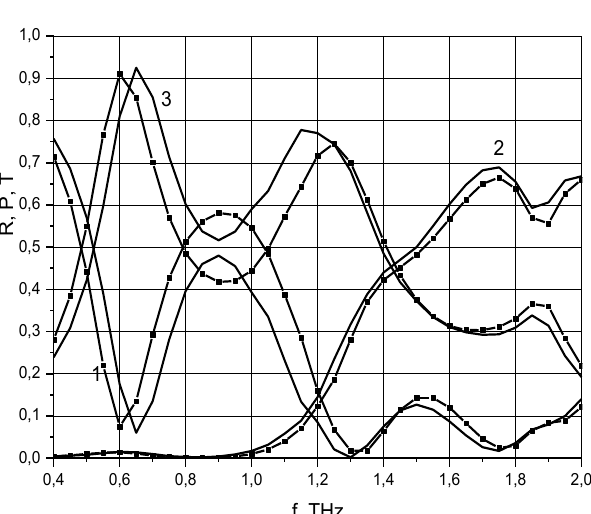
Fig. 6. Frequency dependences of the reflection, transmittance coefficients and losses in the resonance metasurfaces of single square graphene strip in the unit cell based on multilayered graphene-dielrectric substrate for different periodicity (density) of array : Curves 1 — R , 2 — T , 3 — P. w = l = 50 μ m, h d =25 μ m, and n d = 1.77. Nine-layer structure. Parameters of graphene are T = 300 K, μ c = 0.25 eV, and τ = 1 ps. Lines with symbols are sizes of a = b =70 μ m; without symbols, a = b = 80 μ